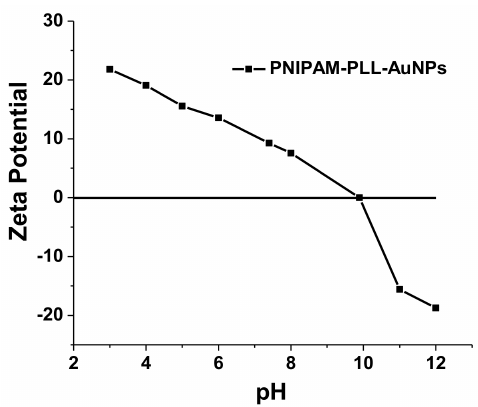
Figure 3. Curve of Zeta -potential versus pH for